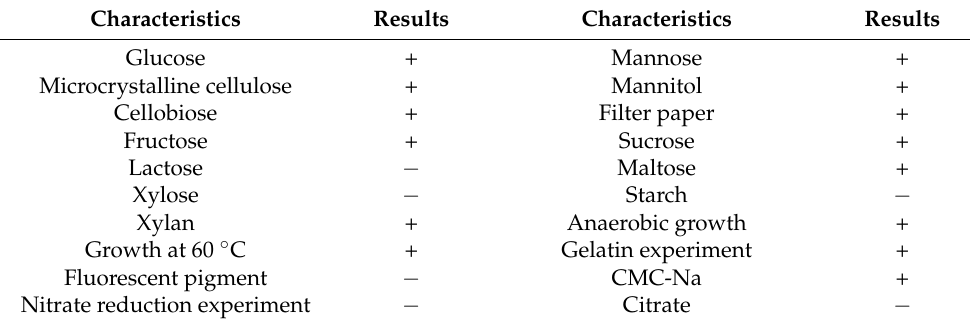
Table 3. Physiological and biochemical characteristics of FC811 strain.